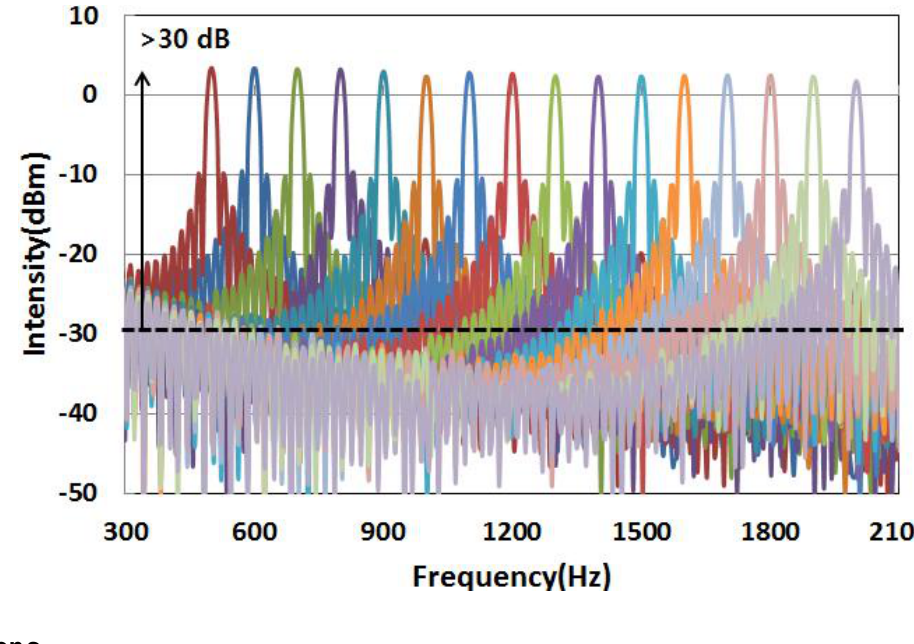
Figure 8. Power spectral density of the FFT spectrum based on varying the frequency of the applied sinusoidal waveform from 500 Hz to 2